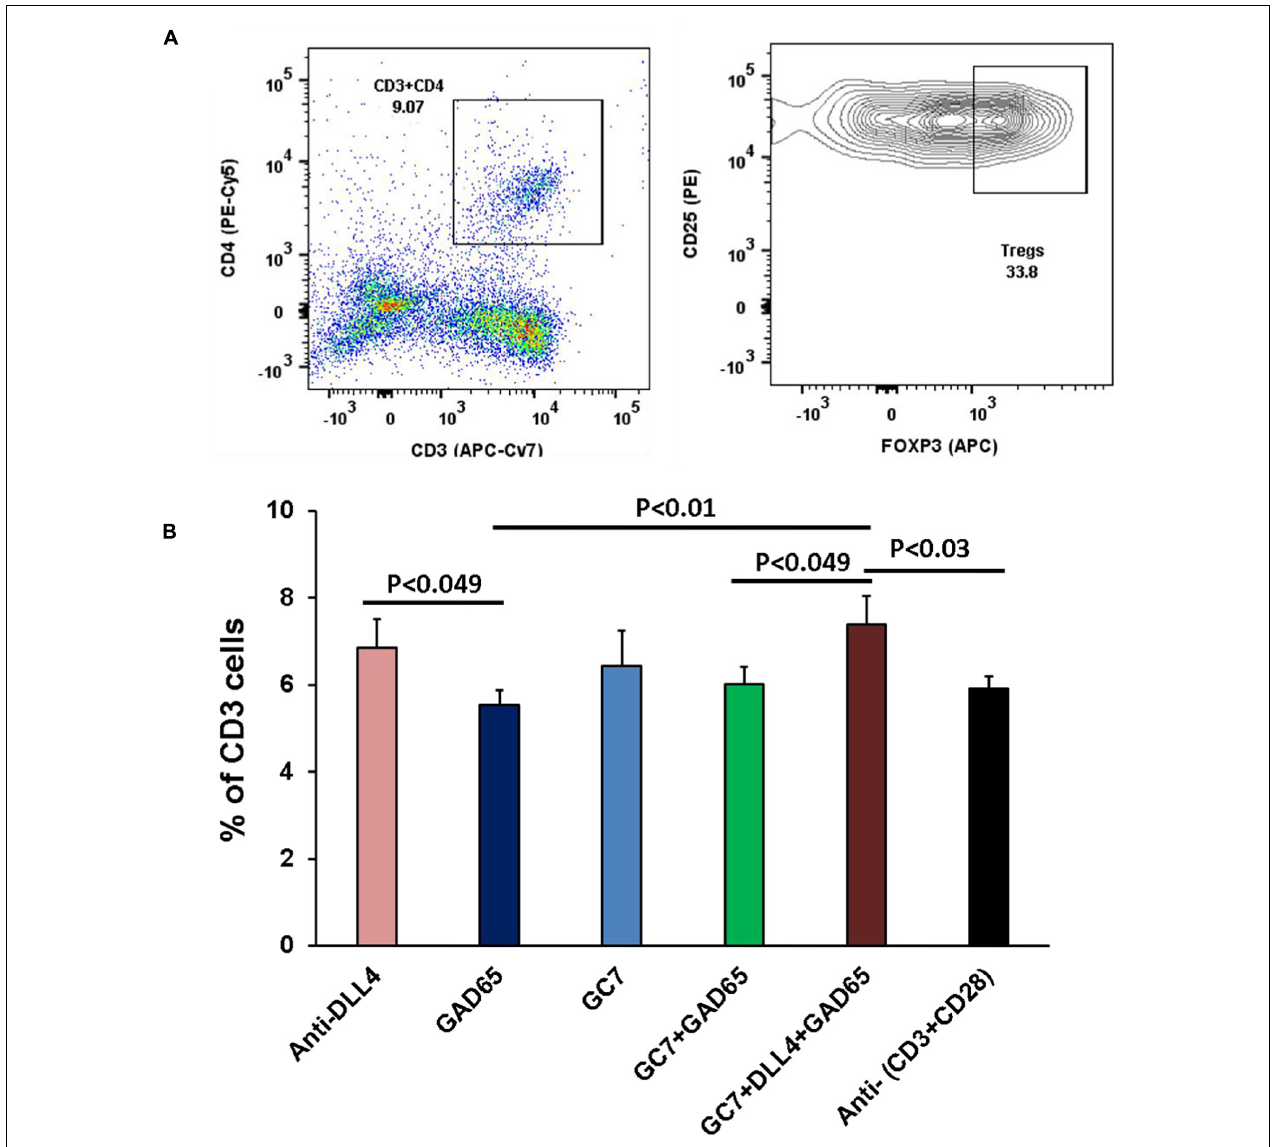
FIGURE 6 | In vitro expression of CD25 and FOXP3 in Tregs after co-stimulation. Representative flow-cytometry (dot plots and contour plots) of in vitro stimulated T cells, isolated from PLN of T1D mice (A) . Single-cell suspensions were stained with fluorochrome-conjugated antibodies. CD3 T cells were gated for CD4 and subsequently gated for Treg cells (CD25 + FOXP3). Each sample was co-cultured in triplicate ( n = 8 animal per group). In vitro stimulation with anti-DLL4, GC7, GC7 + rhGAD65, anti-DLL4 + GC7 + rhGAD65 significantly enriched Treg population (B) by increasing the expression of CD25 and FOXP3 on CD4 T